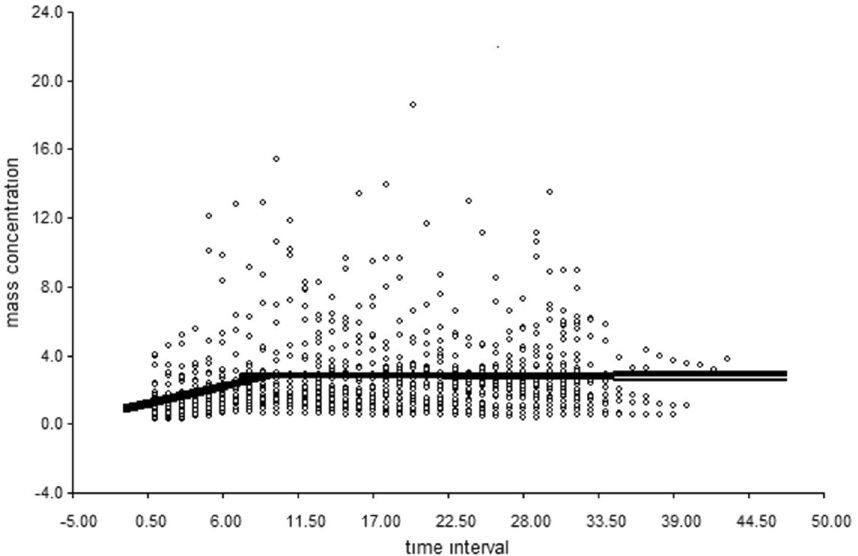
Figure 4. Respirable PM concentrations trend throughout the workday. There is a growing trend until the breakpoint with a subsequent straight